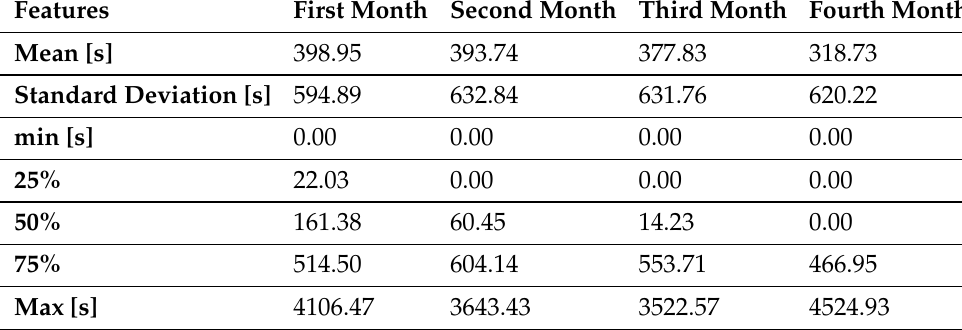
Table 3. Descriptive data for monthly training sessions.